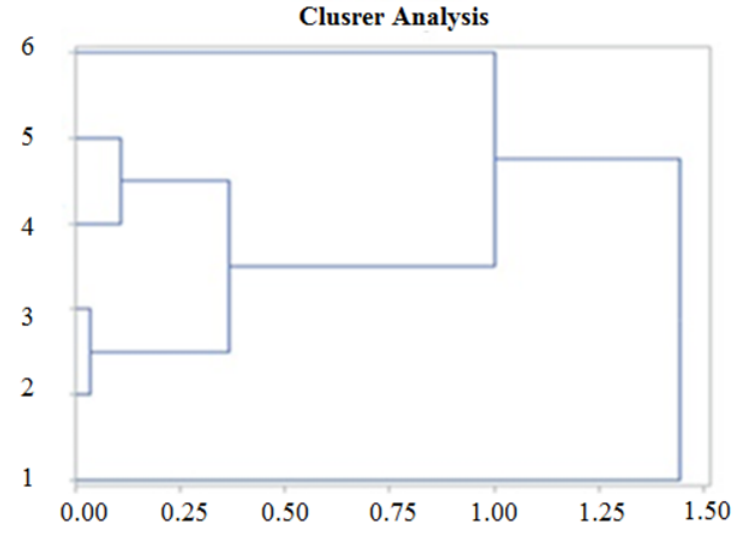
Figure 6. Dendrogram for different agrotechnical treatments. 1 — Control; 2 — Fertilizer with biostimulation 1% — the herbicide belt; 3 — Fertilizer with biostimulation 1% — soaking 1 h; 4 — Fertilizer with biostimulation 1% — soaking 12 h; 5 — Agrogel; 6 — Fertilizer with biostimulation 1% +